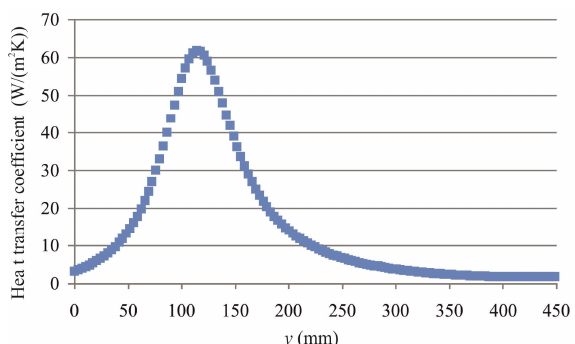
Fig.8 . The heat transfer coefficient at the vehicle's windscreen – vehicle cabin’s air